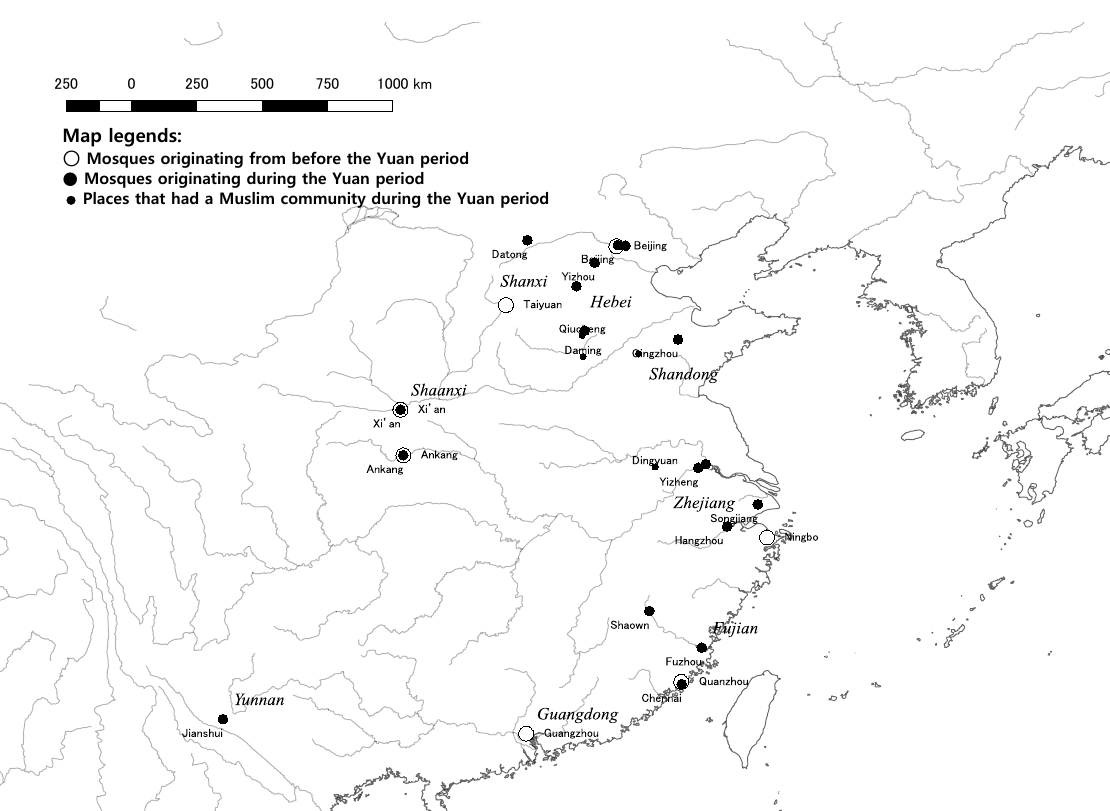
Figure 2 Locations of old mosques in mainland China, according to local tradition. Source: Wu (1995).